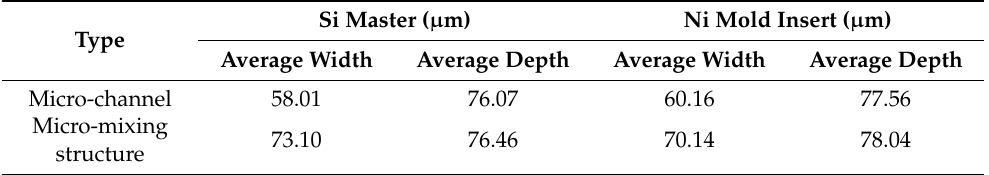
Figure 3. Designed microfluidic chip structure: ( a ) Ni mold insert, ( b , c ) micro-channel and micro- mixing structure characterized by confocal microscope, respectively. Table 1. The average dimensions of Si master and Ni mold